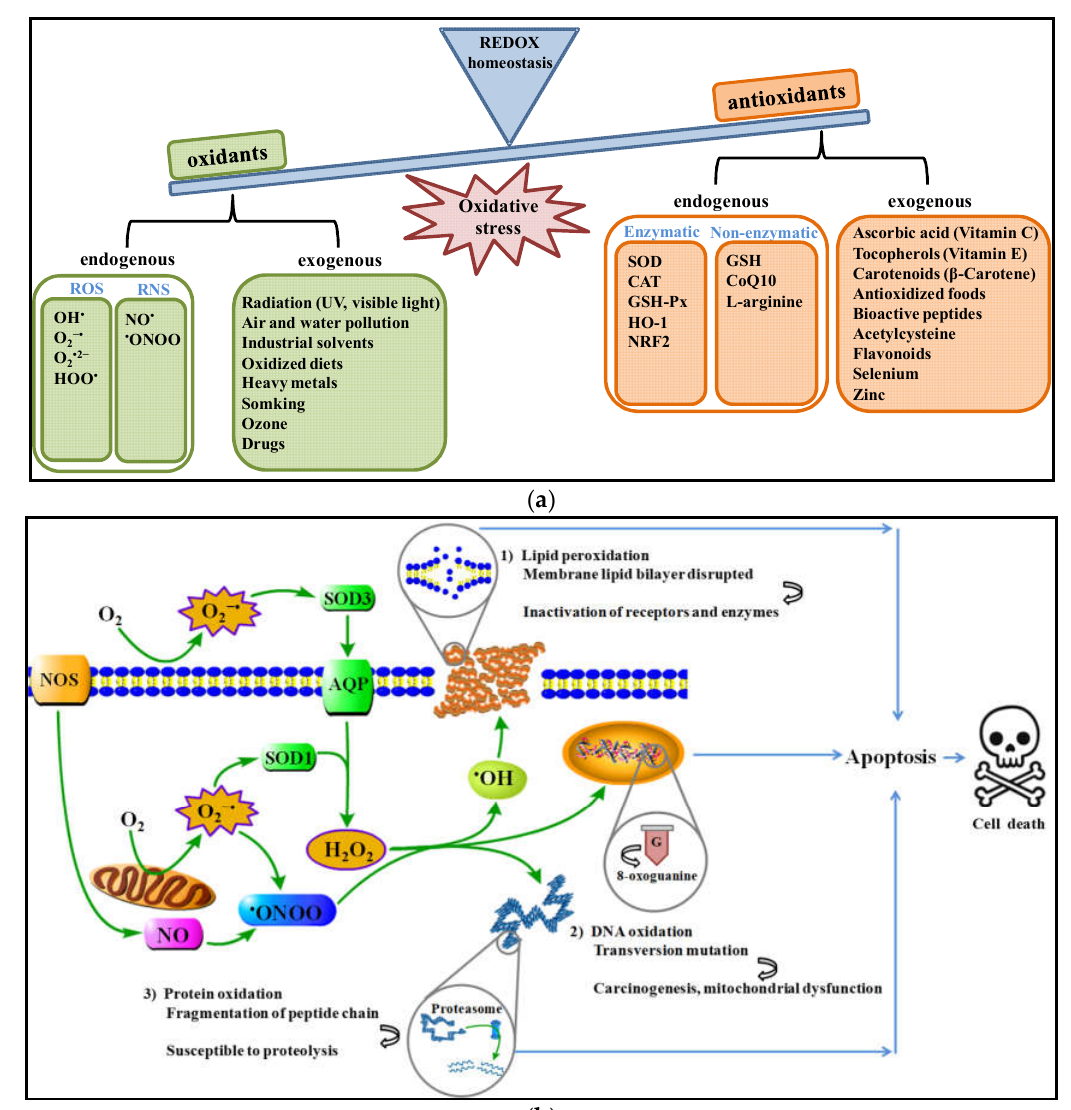
Figure 1. Basic concepts and components of oxidative stress. ( a ) Oxidative stress depends on the imbalance between free radicals and antioxidant systems; ( b ) the effect of oxidative damage on bio- molecules of DNA, proteins, and lipids. Abbreviation: REDOX, oxidation-reduction; ROS, reactive